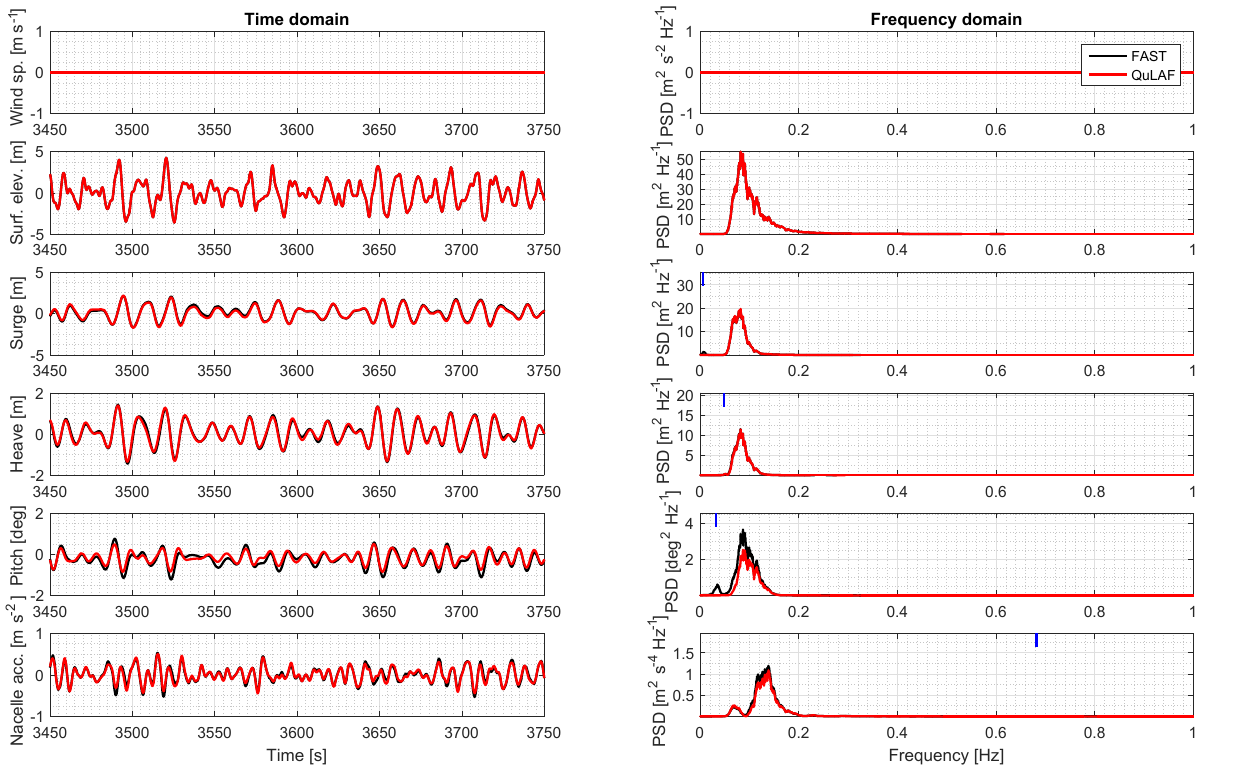
Figure 7. Response to irregular waves in the time and frequency domains.